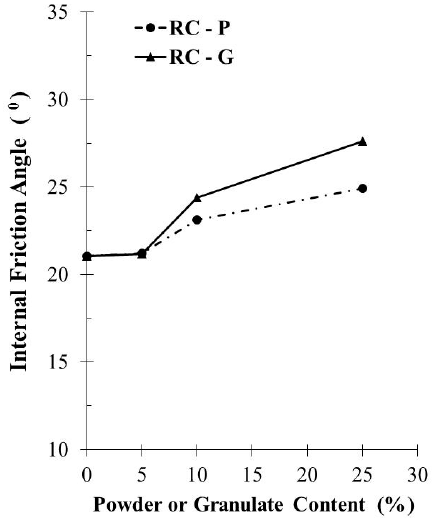
Figure 4. Variation of the angle of internal friction with the rubber waste content.